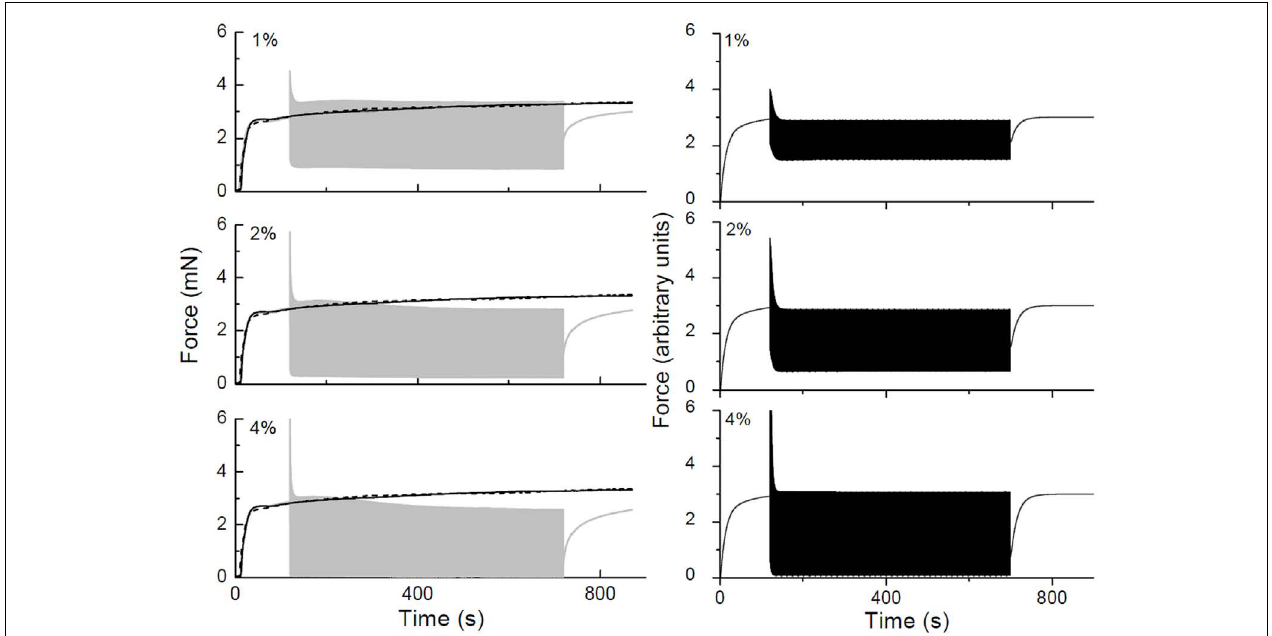
oscillation data, dashed lines obtained afterward).The black curves in the right-hand panels show corresponding force-time plots simulated by a lumped-parameter model of the ASM strip that includes an empirical mechanism accounting for cross-bridge attachment and detachment